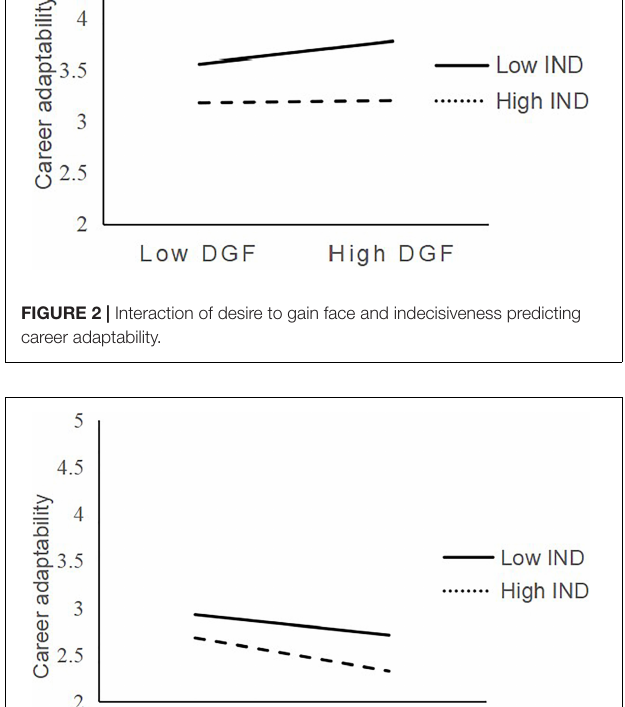
low ( b = − 0.072, SE = 0.054, ns ). Hence, H5b was supported.